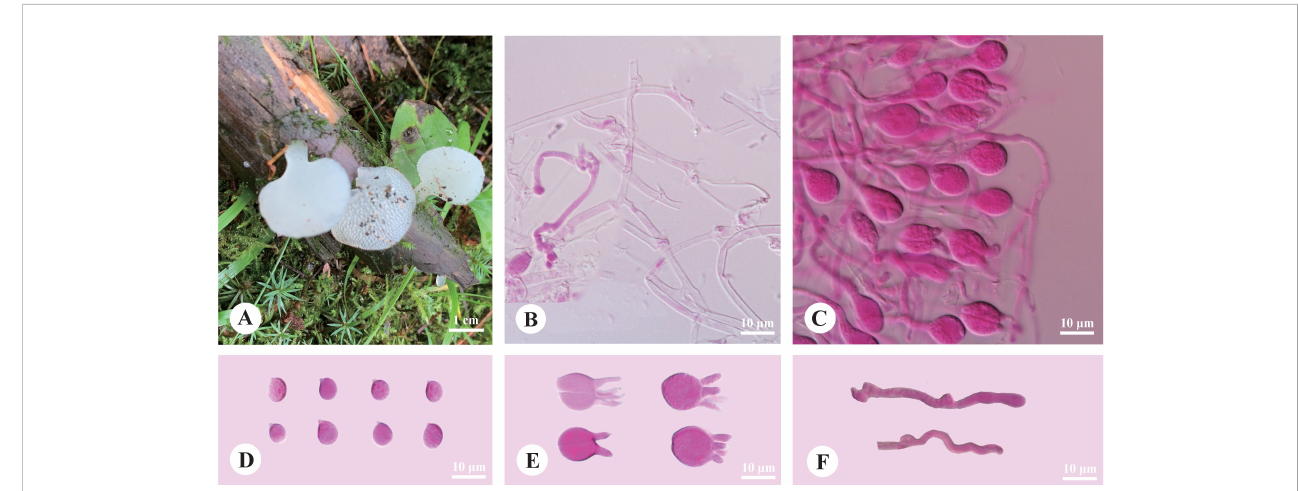
FIGURE 3 Basidiomata and microscopic structures of Pseudohydnum candidissimum (holotype, Dai 23740). (A) Basidiomata; (B) Tramal hyphae; (C) A section of hymenium; (D) Basidiospores; (E) Basidia; (F)